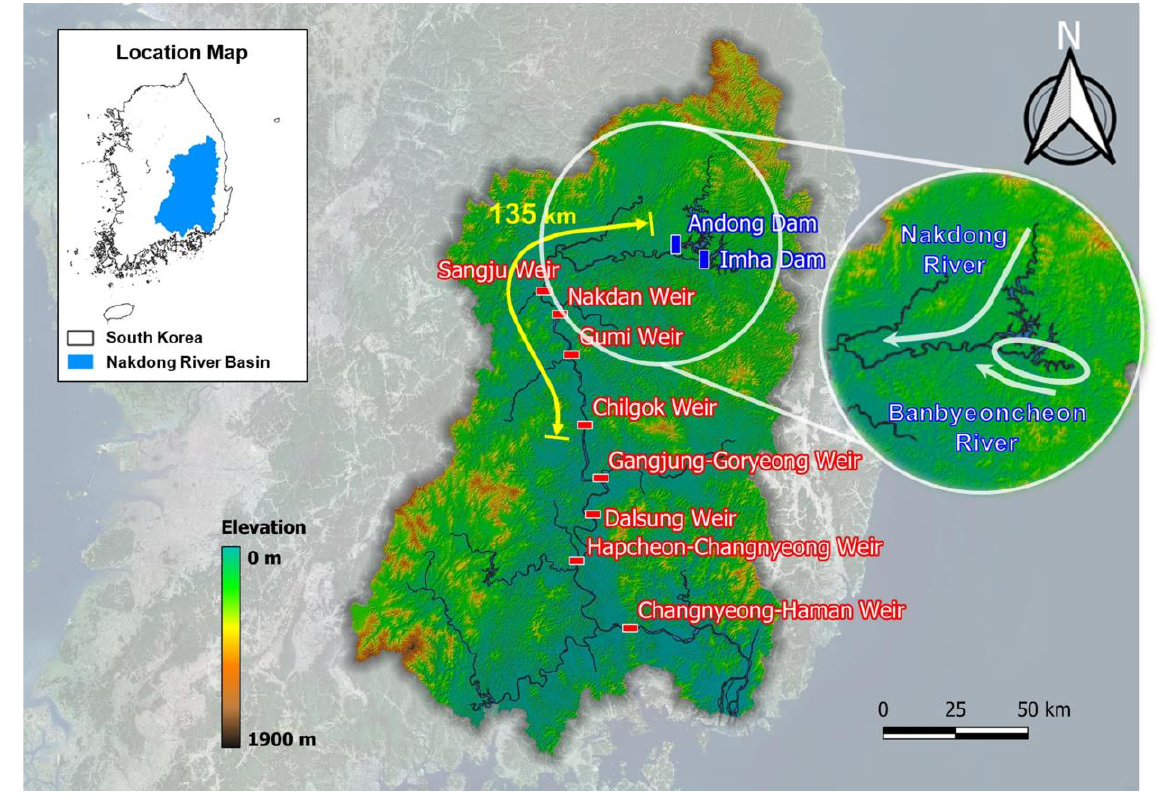
Figure 1. Location of the study area. Table 1. Details about Andong and Imha reservoirs. Table 2. Details about Sangju, Nakdan, Gumi, and Chilgok